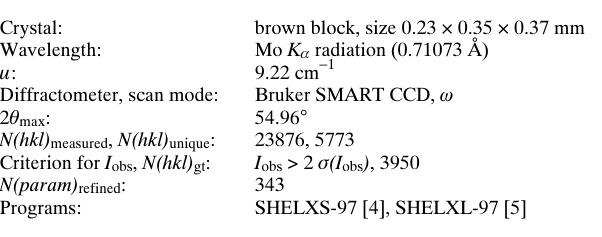
Table 1. Datacollection and handling.